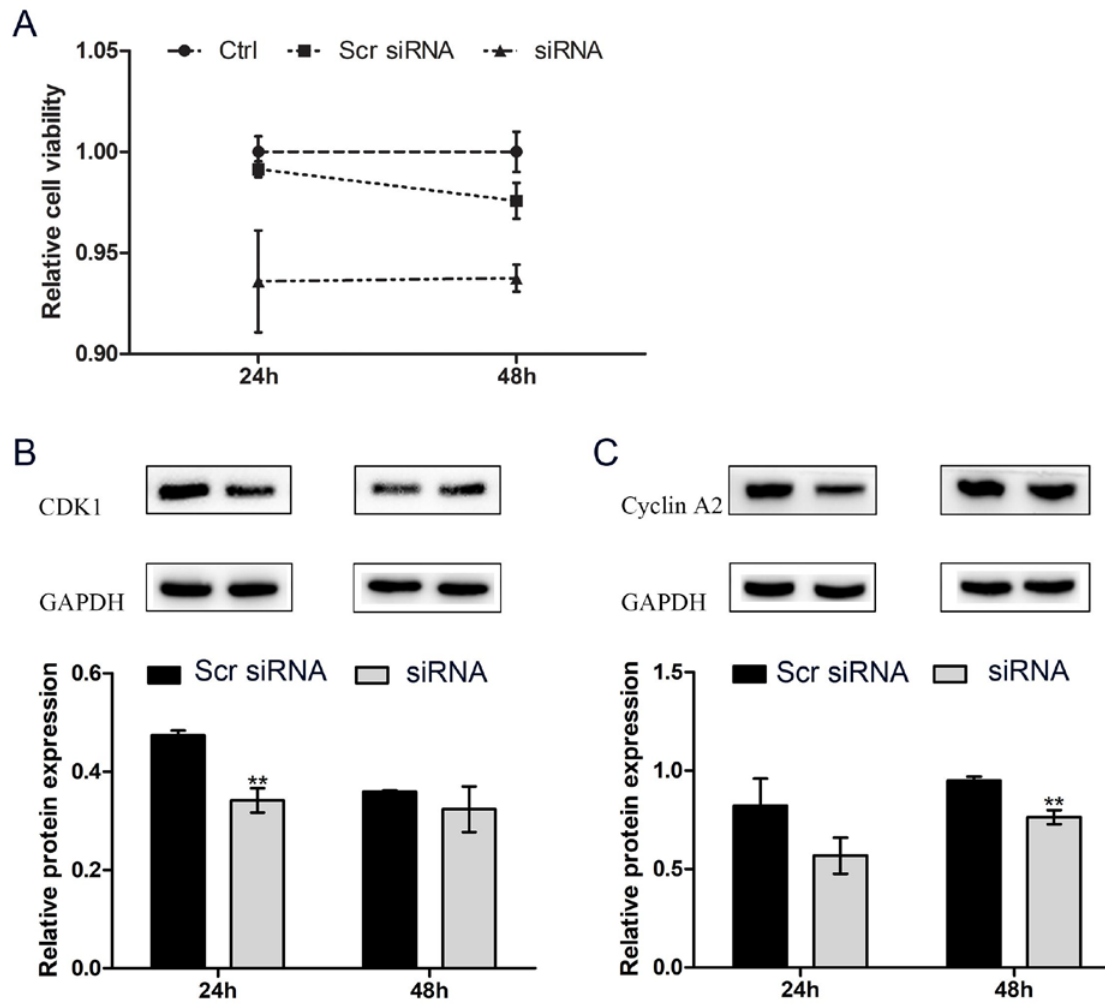
Figure 3. CircHIPK3 knockdown represses the proliferation of HC11 cells. ( A ) Relative cell viability of HC11 measured by CCK-8; ( B ) CDK1 protein expression; ( C ) Cyclin A2 protein expression. Mean ± SEM of three samples from three independent experiments. * p < 0.05; ** p < 0.01.